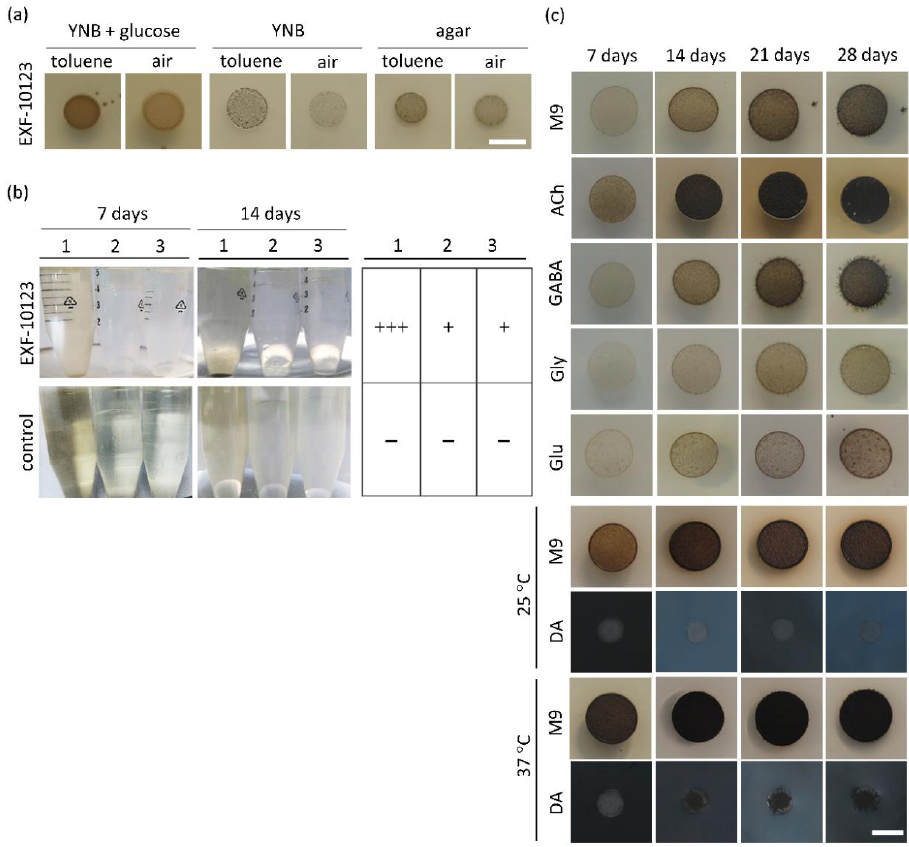
Figure 2. Exophiala dermatitidis assimilated selected cyclic aromatic hydrocarbons and neurotransmitters as sole carbon sources. ( a ) Growth of E. dermatitidis was assessed on solid yeast nitrogen base (YNB) medium, with and without glucose and ultra-pure agar plates without carbon source added. Plates were incubated for seven days under toluene vapours and compared with a control (without toluene vapours). ( b ) E. dermatitidis growth was assessed as well in liquid YNB media with different carbon sources: glucose (1), mineral oil (2), and n-hexadecane (3); incubated for 7 and 14 days; and compared to control (without fungus). Growth rate was qualitatively estimated with a tabular overview. ( c ) Four-week monitored experiment for determining growth and morphological characteristics of E. dermatitidis on solid M9 medium supplemented with various neurotransmitters, ACh, GABA, Gly, Glu, and